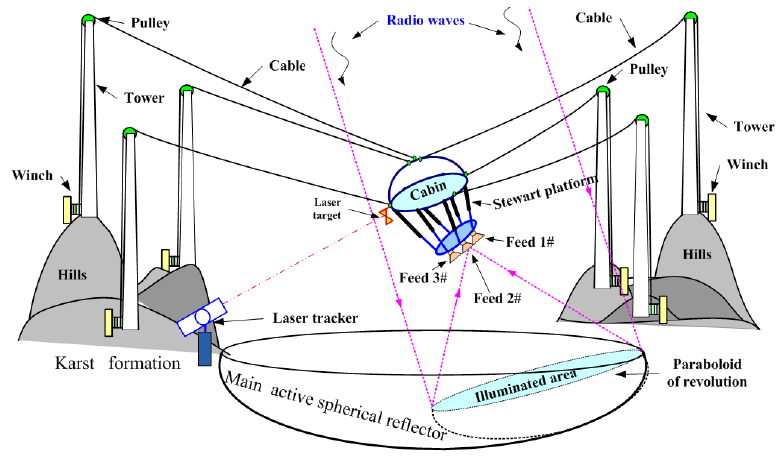
Figure 1. Overview schematic of the supporting structure for five-hundred-meter aperture spherical radio telescope (FAST).